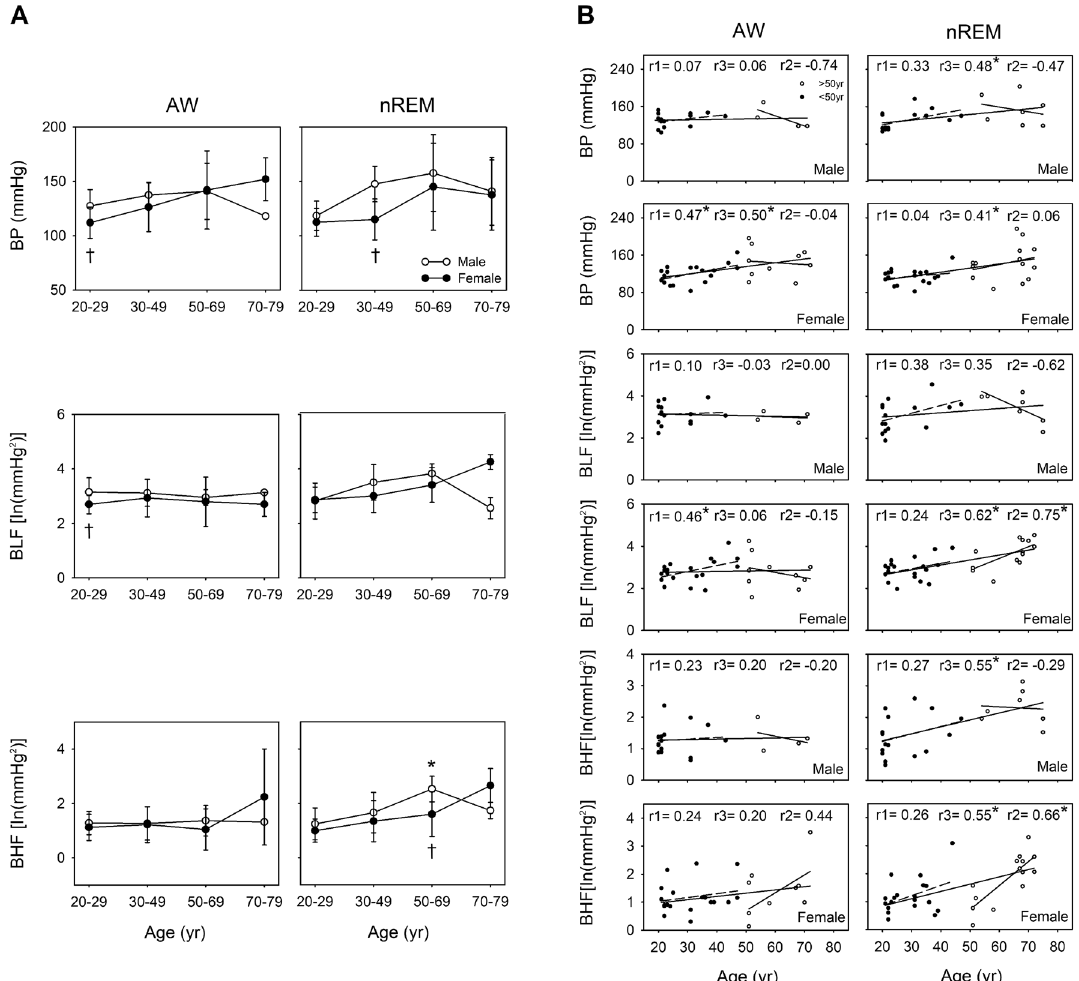
Figure 3. Comparison of blood pressure (BP)/arterial pressure variability (APV) between wakefulness (AW) and non-rapid eye movement sleep (nREM) for the different age groups in men and women ( A ). * p < 0.05 vs. 20–29-year age group. † p < 0.05 vs. men. The values are presented as means ± SEMs. Two-dimensional scattergrams for the BP/APV–age relationship during AW and nREM in men and women ( B ). * p < 0.05. r1: correlation coefficient in the 20–49-year age group. r2: correlation coefficient of 50–79-year age group. r3: correlation coefficient of 20–79-year age group. Abbreviations: ln, natural logarithm; BLF, LF of arterial pressure